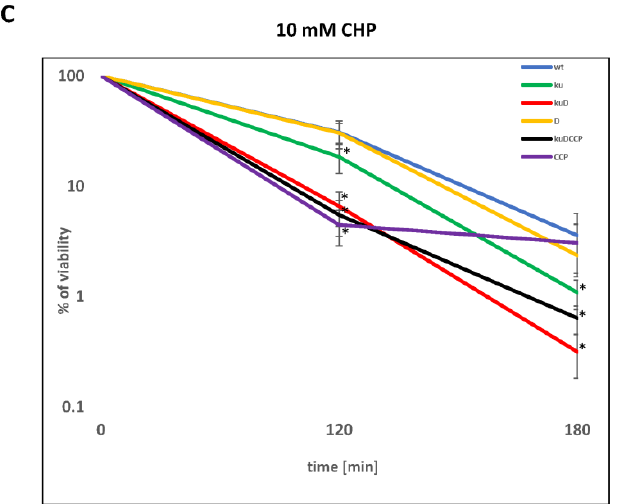
Figure 1. The viability of mycobacteria treated with oxidative and nitrosative agents. The survival of wild-type Mycobacterium ( Mycolicibacterium ) smegmatis (wt) and its mutants (ku-Δ ku , kuD-Δ ku-ligD, D-Δ ligD , kuDCCP-Δ ku-ligD-ligC 1 -ligC 2 -primC , and CCP-Δ ligC 1 -ligC 2 -primC ) treated with methylmethansulfate (MMS) ( A ) or CHP ( B ) 5 mN or ( C ) 10 mM based on the colony-forming unit (CFU) analysis. The bacterial cells were treated with 0.4% MMS for 30 and 60 min ( A ), 5 mM of CHP for 180 min ( B ), and 10 mM of CHP for 120 min and 180 min ( C ). The percentage of survival was calculated by comparing the number of viable cells in treated vs. untreated samples from at least three independent experiments and plotted as the average +/- standard deviation. A Mann–Whitney rank-sum test was employed for comparisons of mutants versus the control samples (mc) to deter- mine any significant differences between the mean values of the wild-type and mutant strains. The results were considered to be statistically significant (*) at p <